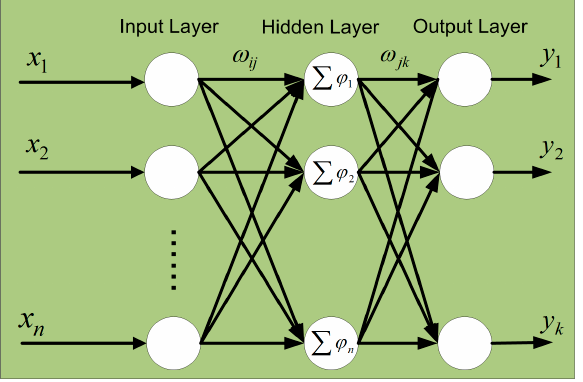
Figure 4. Topological structure of the wavelet neural network